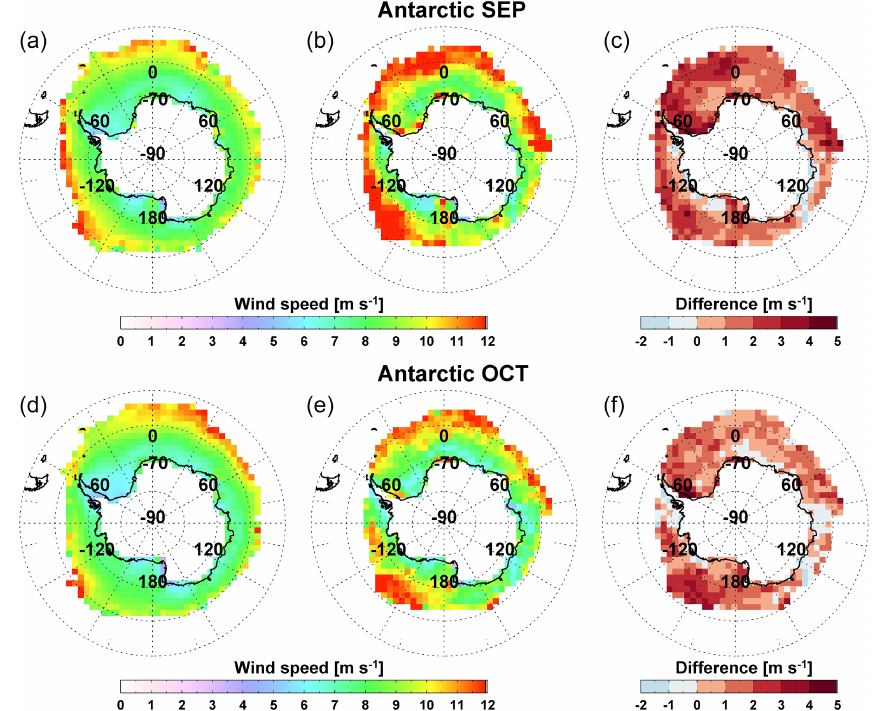
Figure 11. As Fig. 10 but for the Antarctic in September (a–c) and October (d–f)